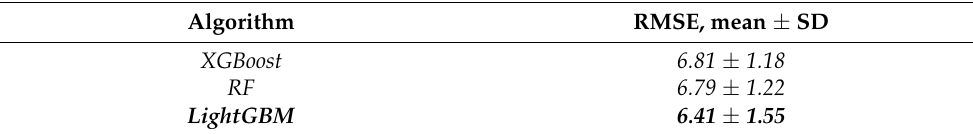
Table 3. Performances of LightGBM, RF, and XGBoost models to predict MV duration over time in MIMIC-III.